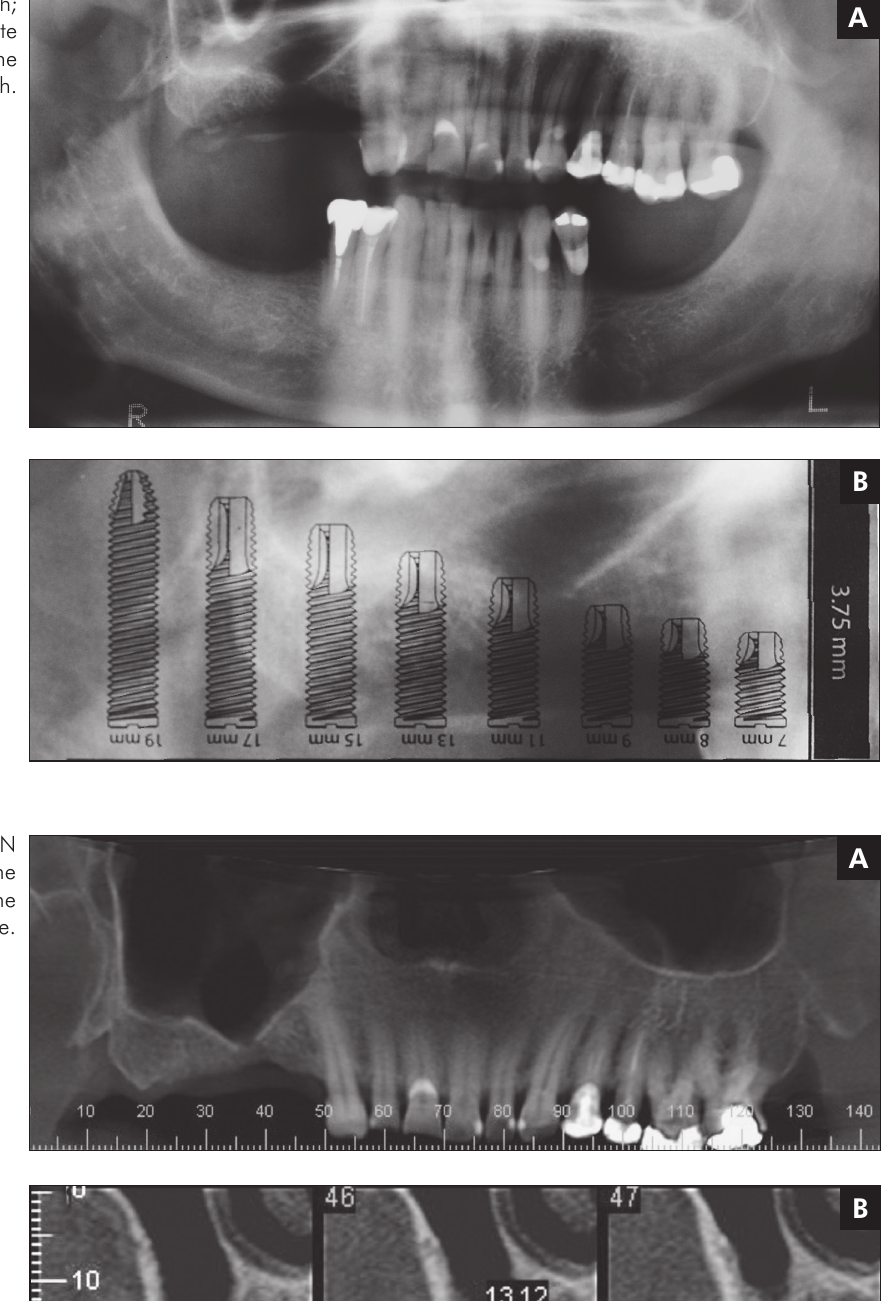
Figure 1 - A: PAN radiograph; B: Transparent template superimposed on the radiograph.